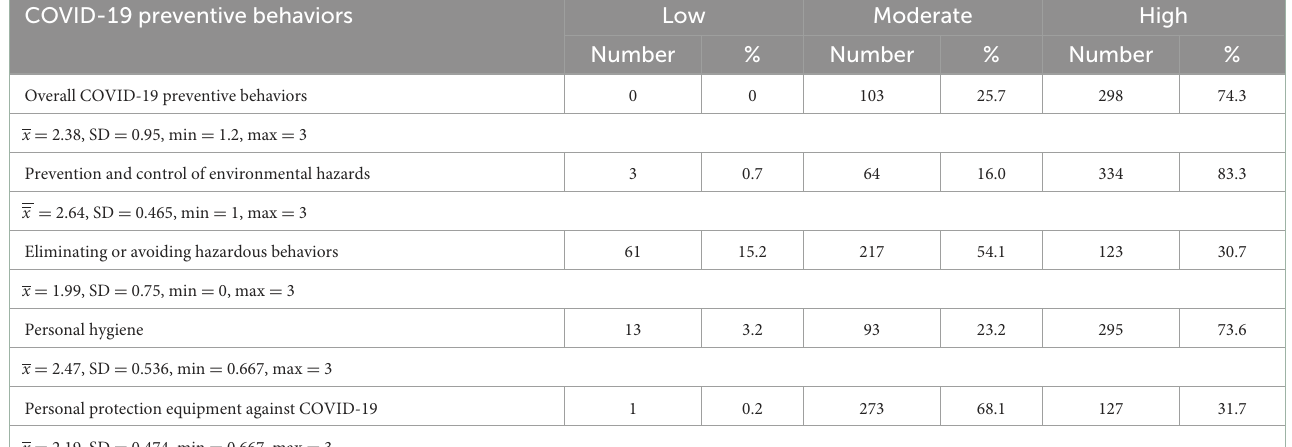
TABLE 5 Descriptive statistics of COVID-19 preventives behaviors among taxi drivers ( N = 401). COVID-19 preventive behaviors Low Moderate